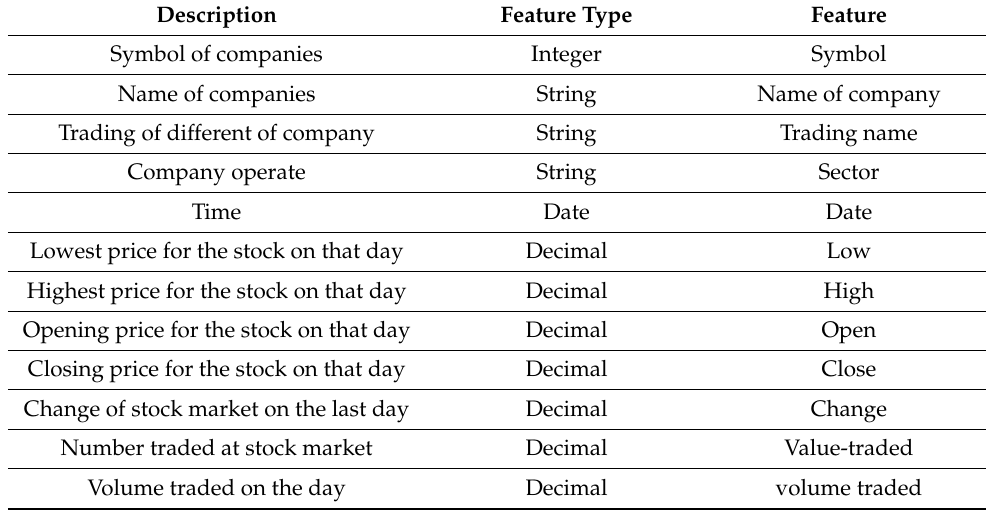
Table 1. Features of the Stock Exchange (Tadawul).